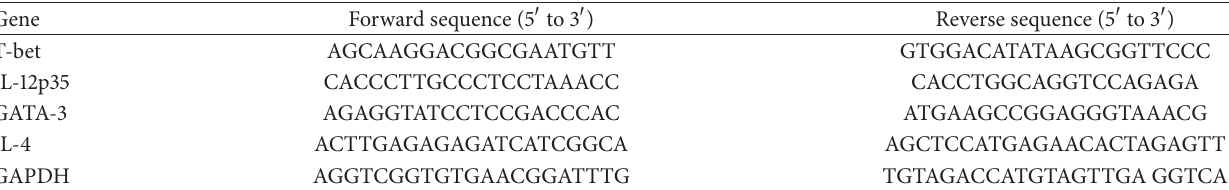
Table 1: Primers for real-time quantitative RT-PCR